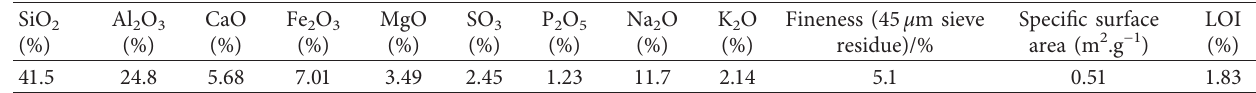
Table 2: Fly ash chemical composition.